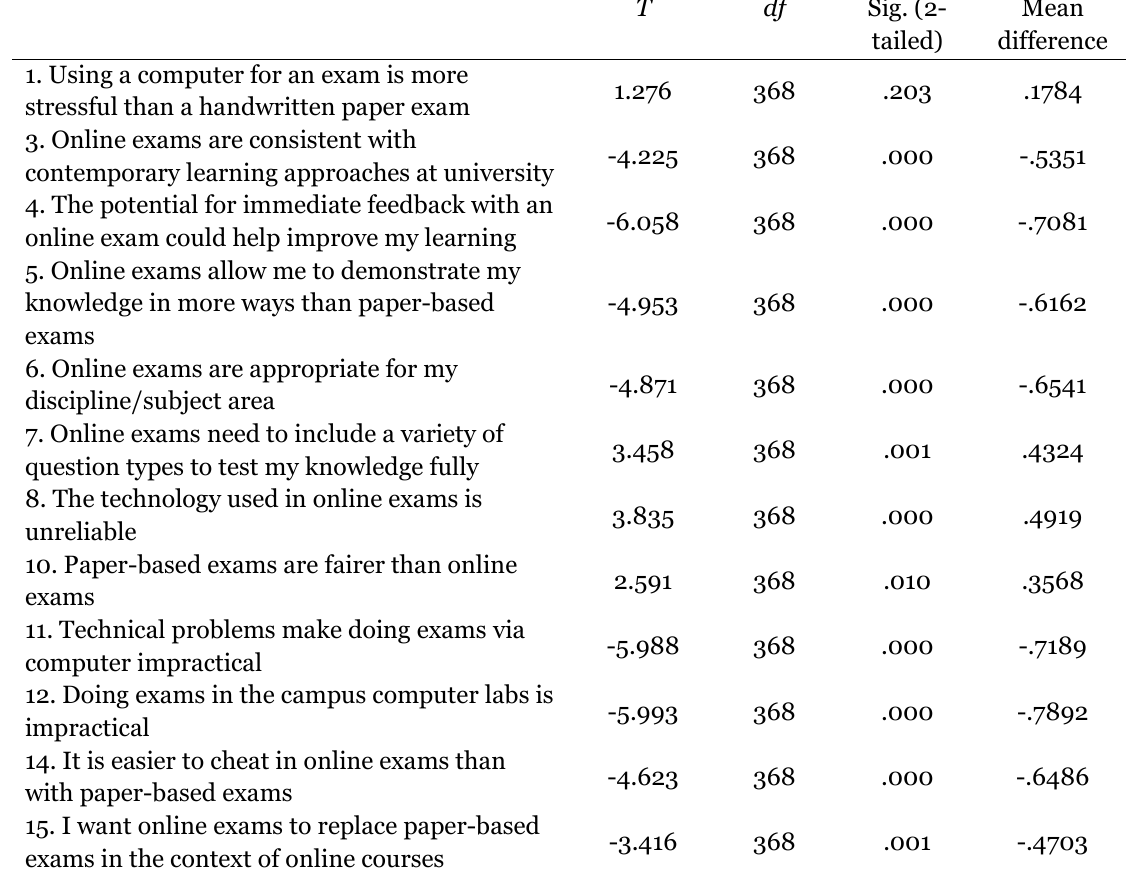
Results of the Independent Samples T-test on Learners’ Perception by Country